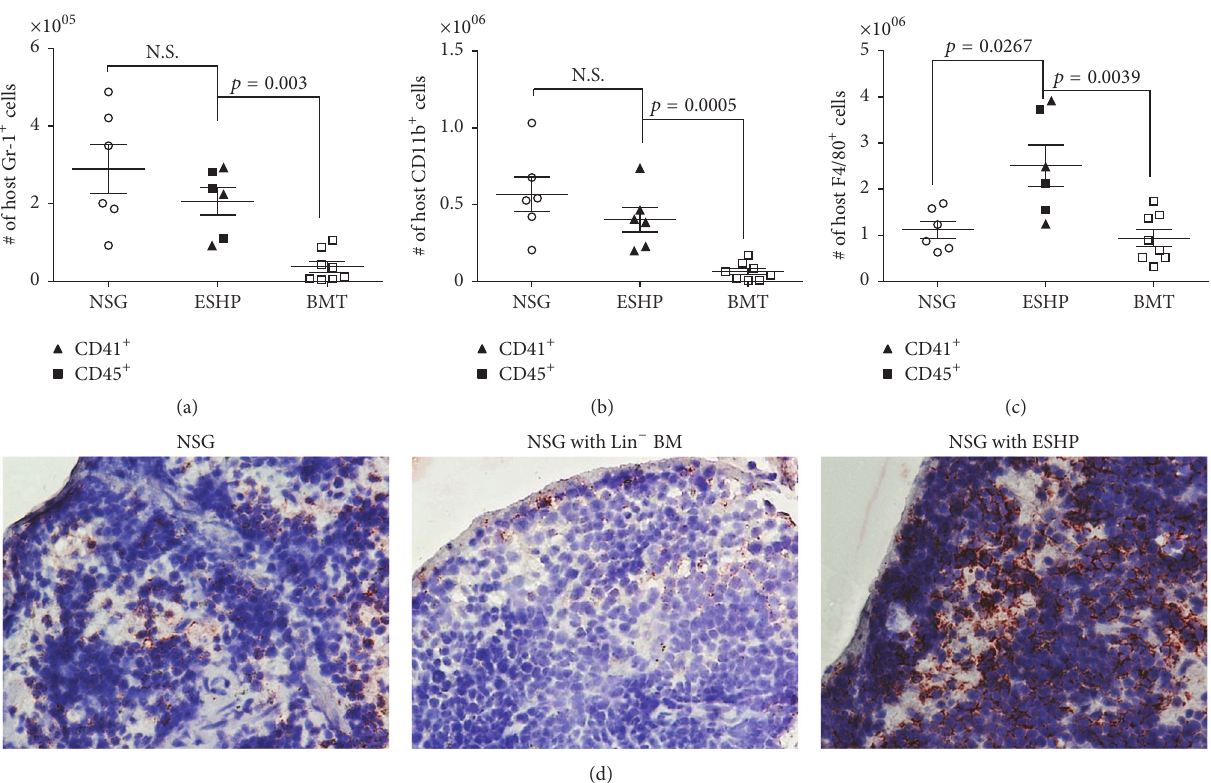
Figure 3: Increase in host F4/80 + splenic macrophages in ESHP recipients. (a) Absolute numbers of host-derived Gr-1 + cells, (b) absolute numbers of host-derived CD11b + cells, (c) absolute numbers of host F4/80 + macrophages in ESHP recipients (CD41 filled triangles, 𝑛 = 3 , and CD45 filled squares, 𝑛 = 3 ), untransplanted NSG mice ( 𝑛 = 6 ), and whole BMT recipients ( 𝑛 = 8 ). Bars represent mean and SEM. (d) Immunohistochemistry of F4/80 + macrophages (red-AEC) in spleen sections at days 17–20 after transplant, taken at 40x magnification.